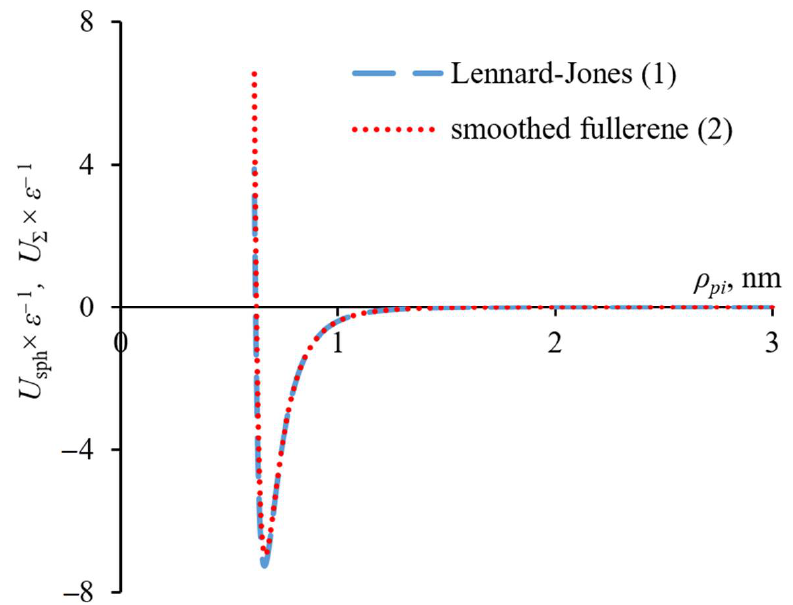
Figure 3. Dependences of relative potential energies for interaction between the C 60 fullerene and single helium atom on the distance between the centers of mass.